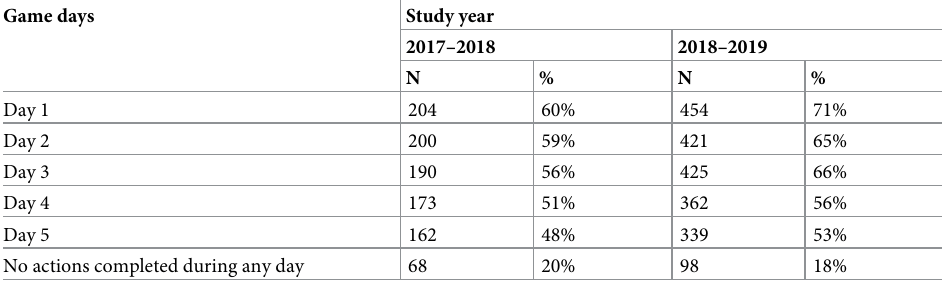
Table 2. Percentage of total students that completed actions on consecutive game